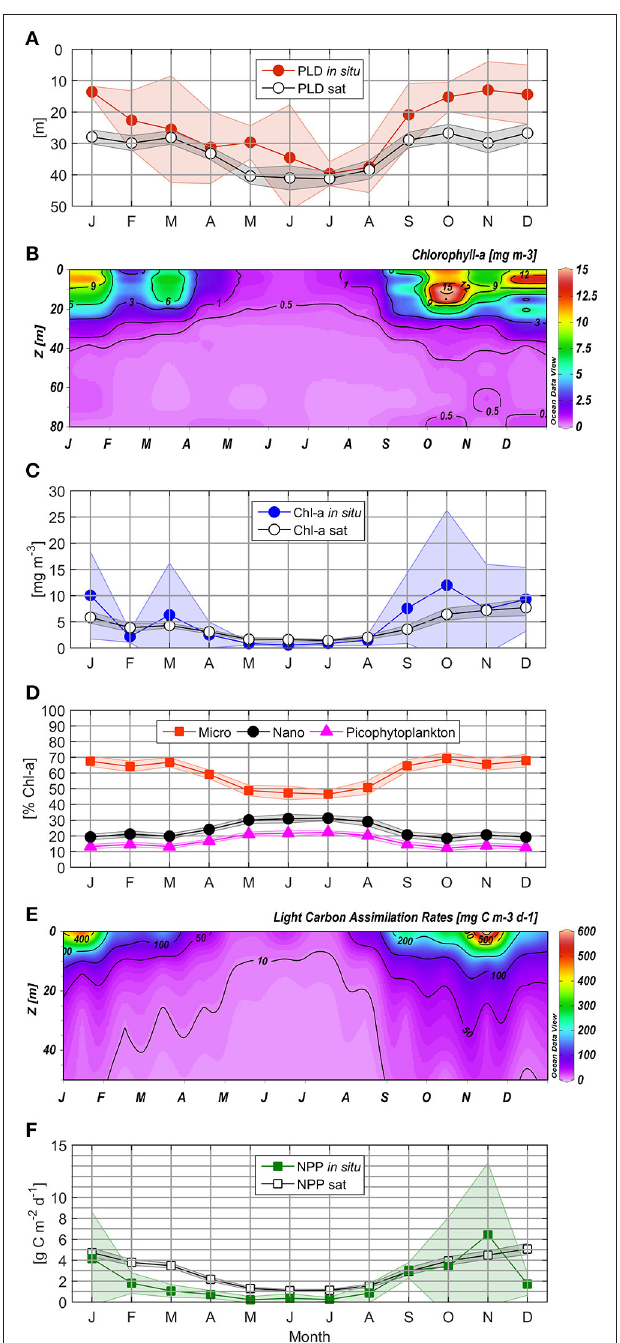
FIGURE 5 | Mean climatology for in situ and satellite Photic Layer Depth (A) , Chlorophyll-a (B) , in situ and satellite surface Chlorophyll-a (C) , Phytoplankton size classes (D) , Light Carbon Assimilation Rates (E) , and in situ and satellite Net Primary Production (F) . Markers indicate monthly mean values; the shaded area indicates monthly 95% confidence interval.